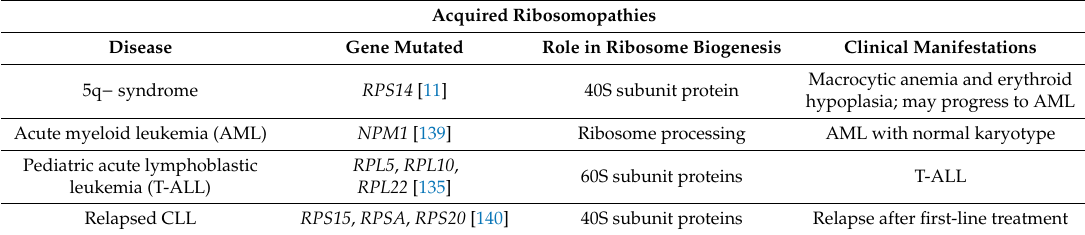
Table 3. Acquired